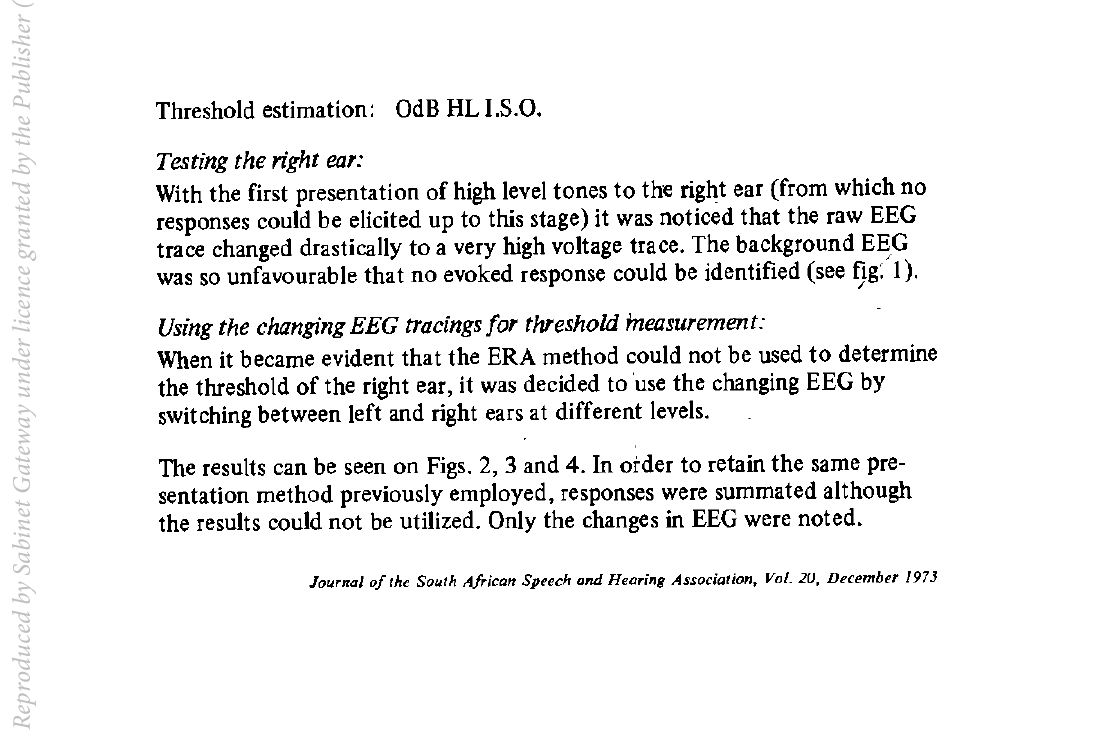
Figure 1. Summated evoked response and raw EEG tracings indicating the difference in the EEG tracings when auditory stimuli are perceived in the right and left ears. Sensitivity: